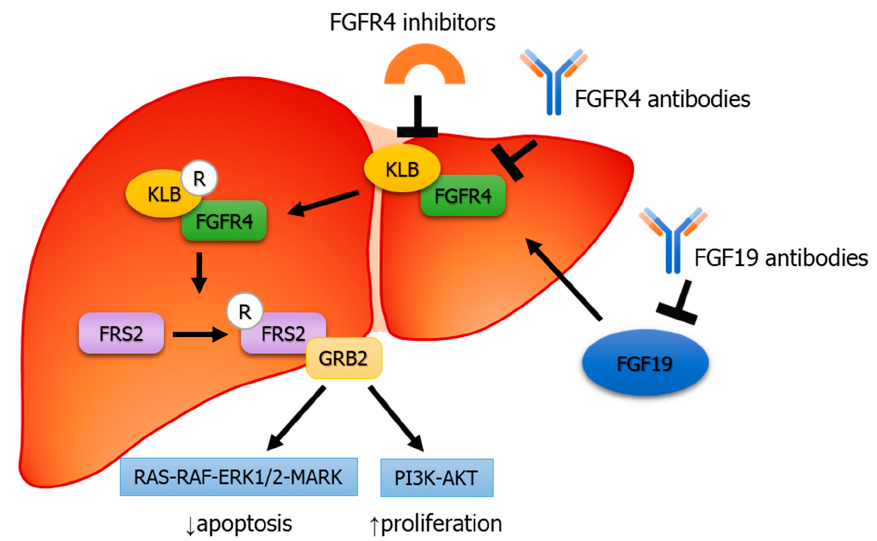
Figure 6. Binding mechanism of FGF19 to FGFR4 leads to FRS2 along with recruitment of growth factor receptor-bound protein 2 ( GRB2 ), ultimately leading to activation of the Ras – Raf – ERK1 / 2 MAPK and PI3K – Akt pathways.